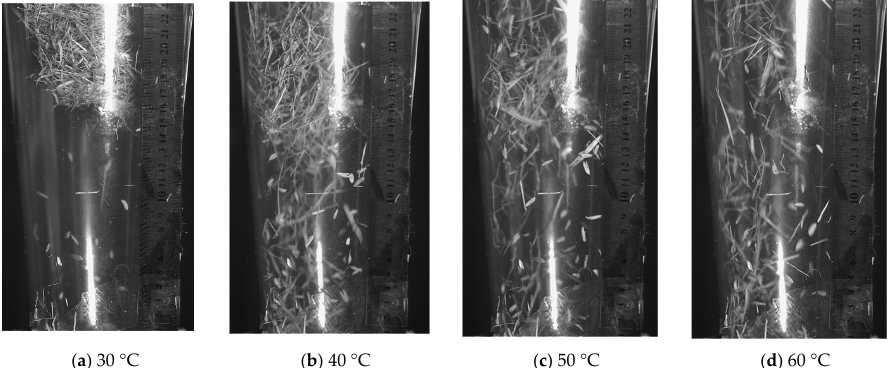
Figure 7. Flow state of wet threshed mixture at different airflow temperatures ( v = 7.60 m/s and t = 8 s).